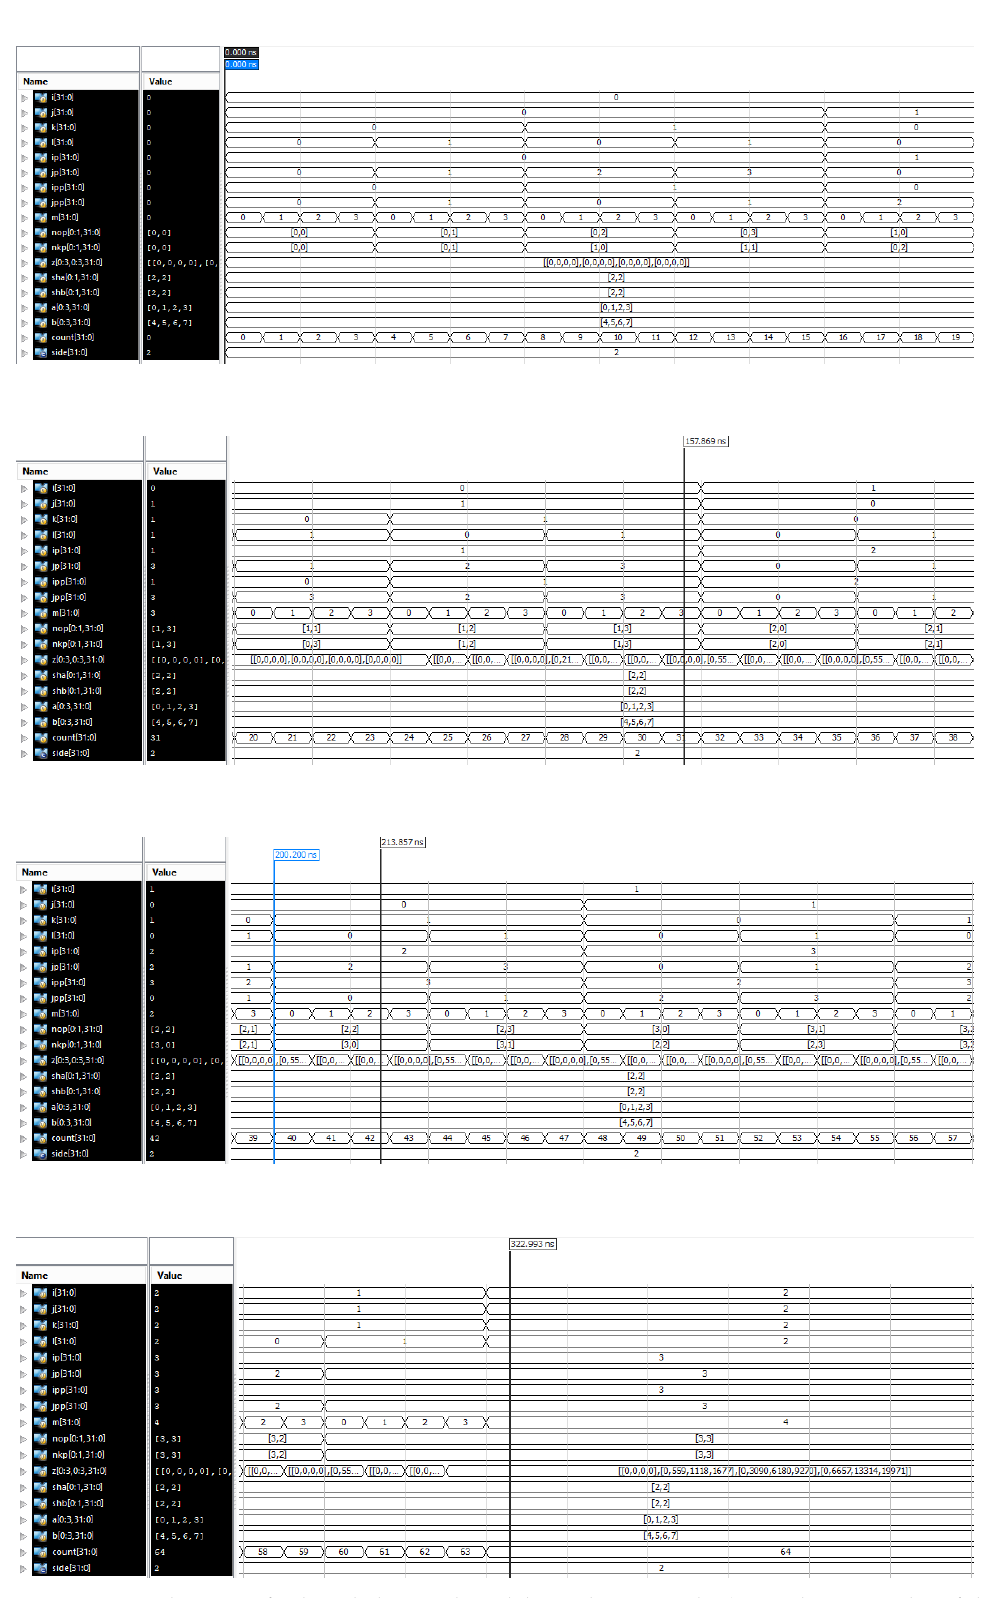
Figure 12. Verilog HDL for-loop behavioral model simulation results (top to bottom order of the waveform plots shows the start to end of simulation